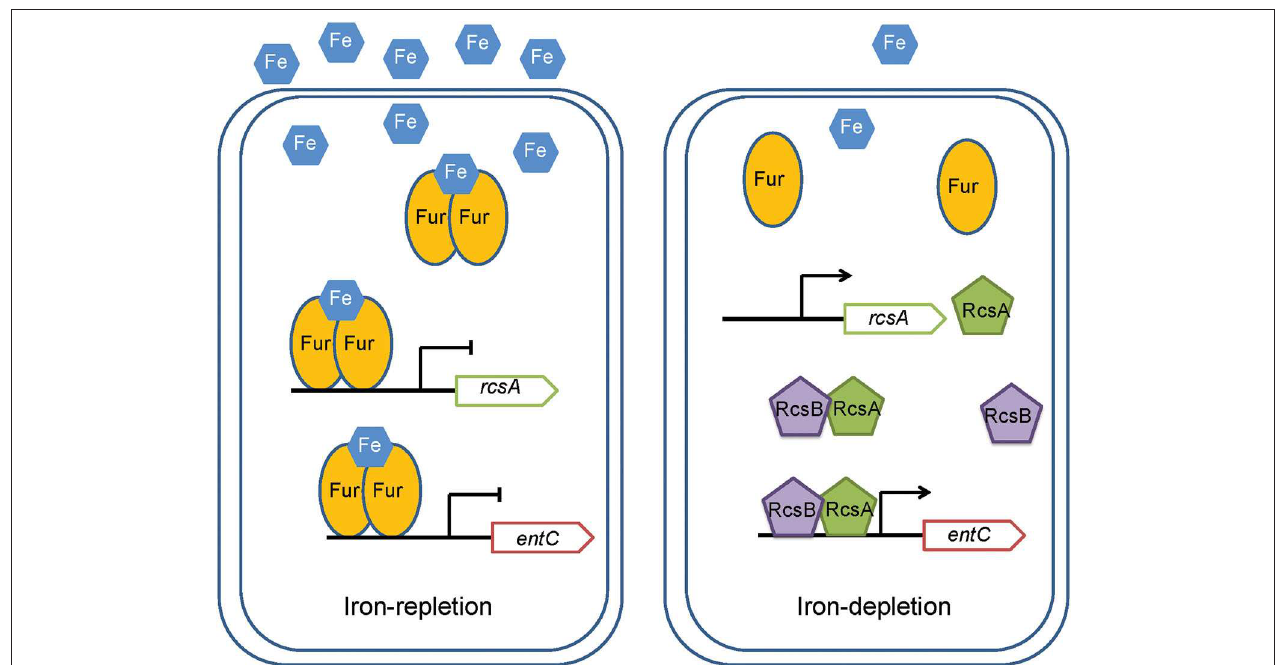
FIGURE 8 | A model for the regulation by RcsAB and Fur of rcsA and entC in K. pneumoniae. Under iron-replete conditions, apo-Fur combines with Fe 2 + to form holo-Fur, which strongly represses rcsA and entC . Under iron depletion, upon derepression by apo-Fur of rcsA and entC and activation of RcsAB, the transcription of entC